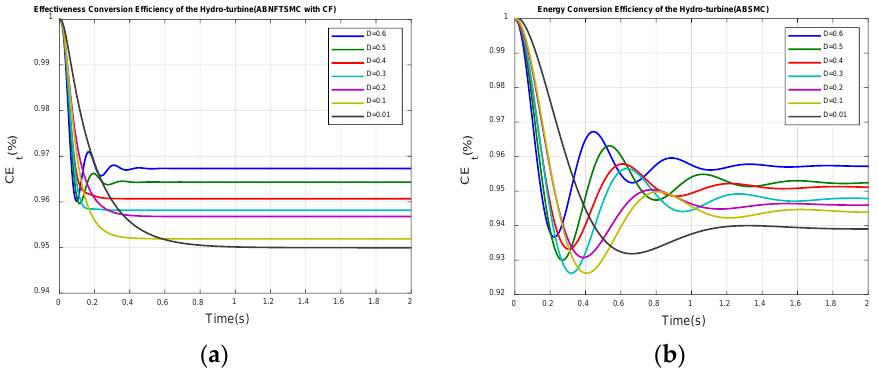
Figure 9. The comparison of energy conversion efficiency of the hydro-turbine with respect to different stochastic intensity D . ( a ) ABNFTSMC with CF method; ( b ) ABSMC [15] method.